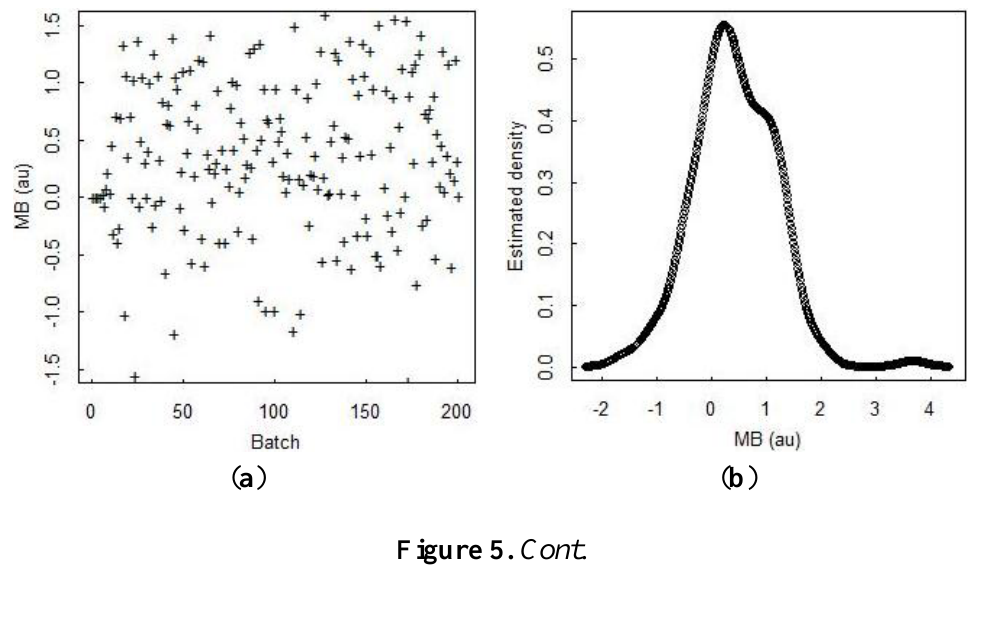
Figure 4. ( a ) Daily total input; ( b ) total inventory in eight vessels; ( c ) total output from four streams; and ( d ) daily (“batch”) MB in generic electrochemical data simulated from the